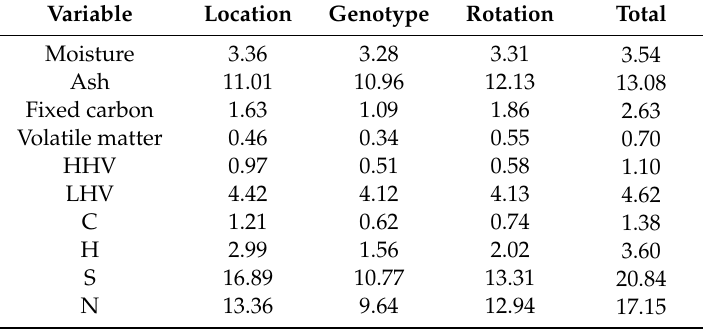
Table 4. Percentage coe ffi cients of variation (CV) for location, genotype, harvest rotation and—in general—for the willow biomass characteristics under